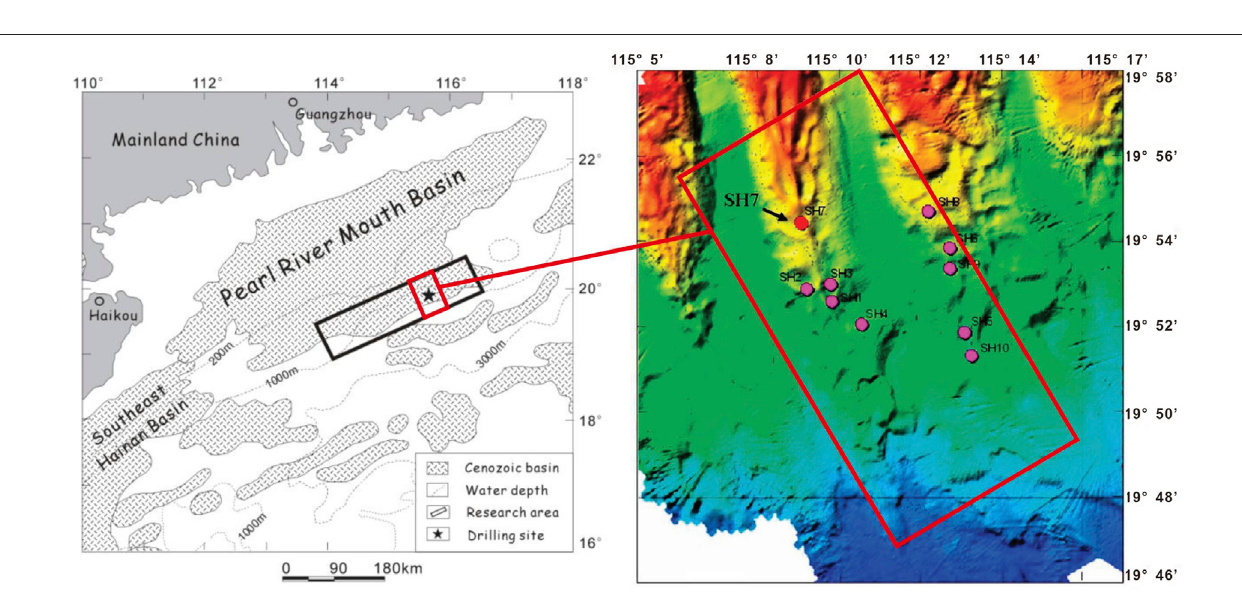
Frontiers in Earth Science |